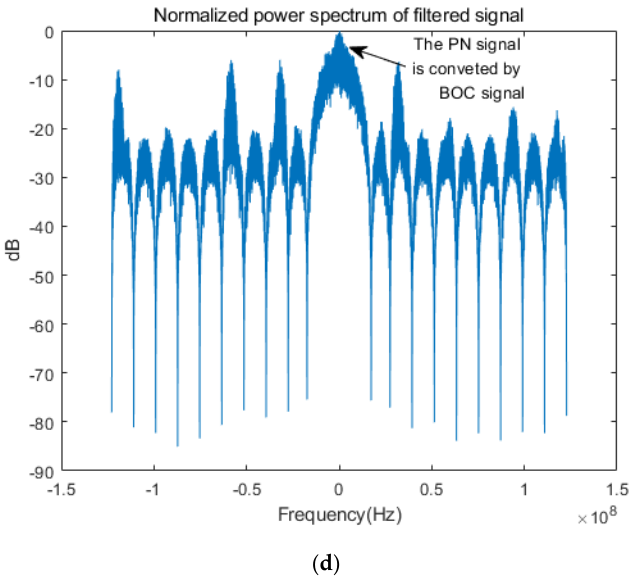
Figure 3. Design of TT&C signal processing. ( a ) Signal acquisition ( b ) Normalized power spectrum of the IF signal ( c ) Normalized power spectrum of the signal after the desubcarrier ( d ) Normalized power spectrum of the signal after the low-pass filter.